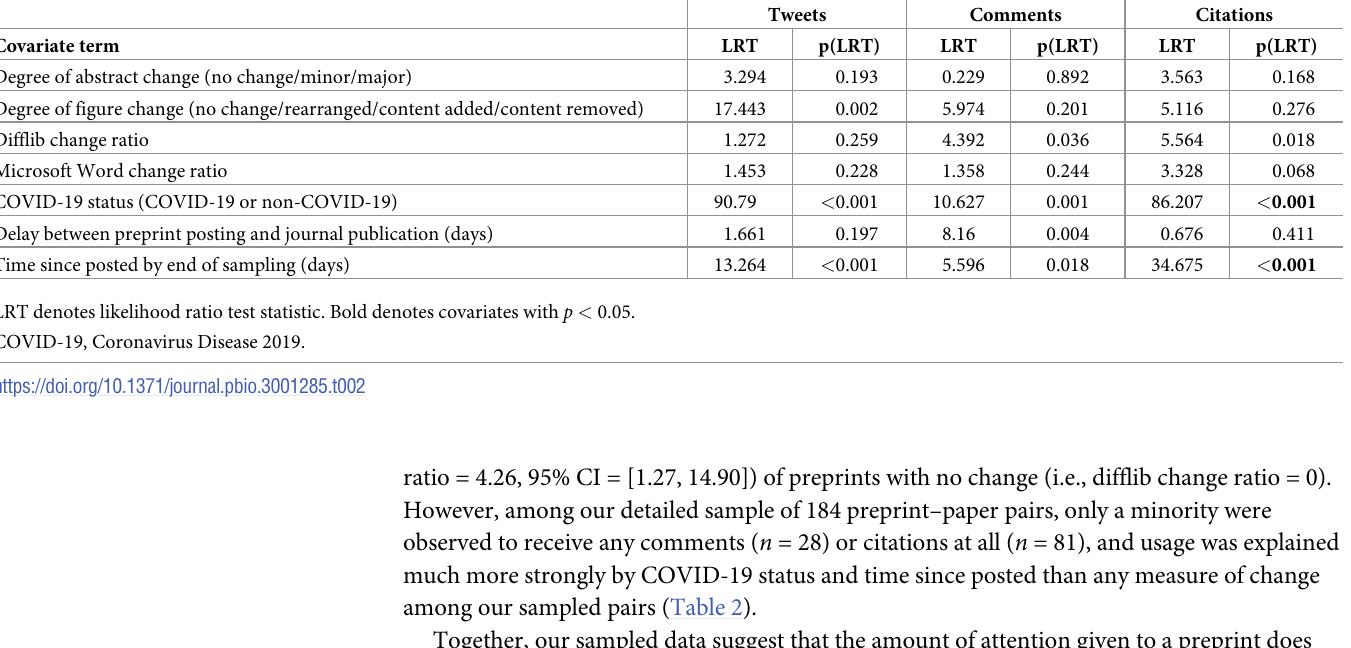
Table 2. Outputs from multivariate negative binomial regressions predicting counts of usage metrics for 184 preprint–paper